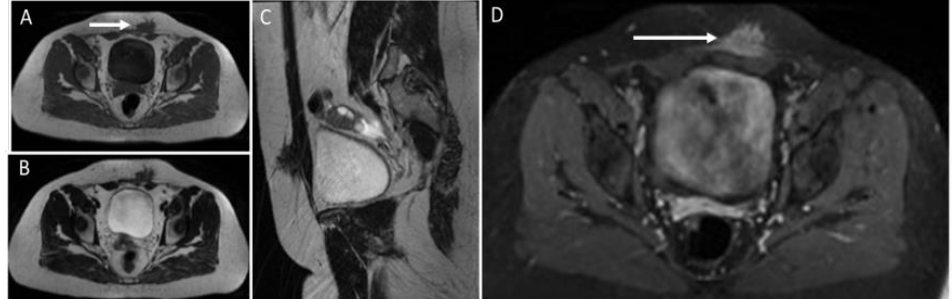
Figure 18. MR study of an endometriotic nodule (arrows) in the left rectus abdominis muscles and subcutaneous tissue. Endometriotic implants inside muscle are well characterized on MR. They show heterogeneously low signal on T1 (A) and T2 images (images B-C) and strong enhancement after the injection of contrast agent (D). Sagittal reconstruction (C) shows the extension of the endometriotic nodule into fat tissue, fascia, and intramuscular location.